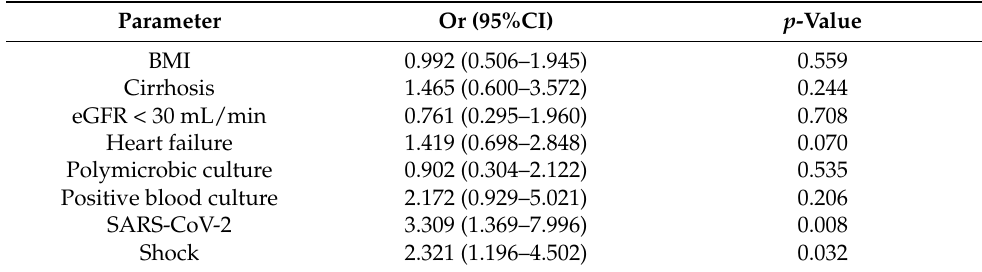
Table 2. Multivariate analysis of factors associated with death in the intensive care unit among patients affected by ventilator-associated pneumonia with or without SARS-CoV-2.